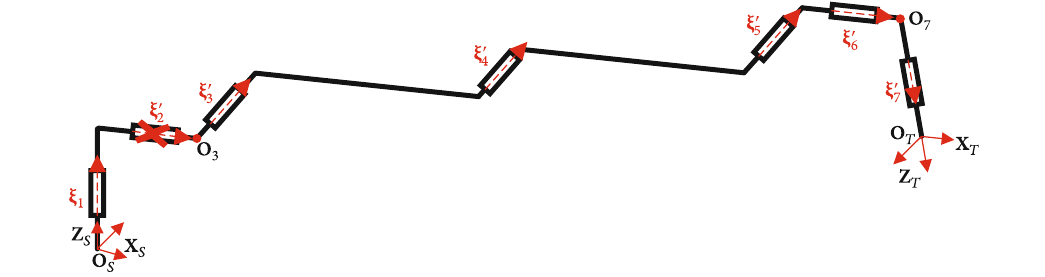
Figure 7: The reconstructed 6-DOF manipulator for locking the 2nd joint.